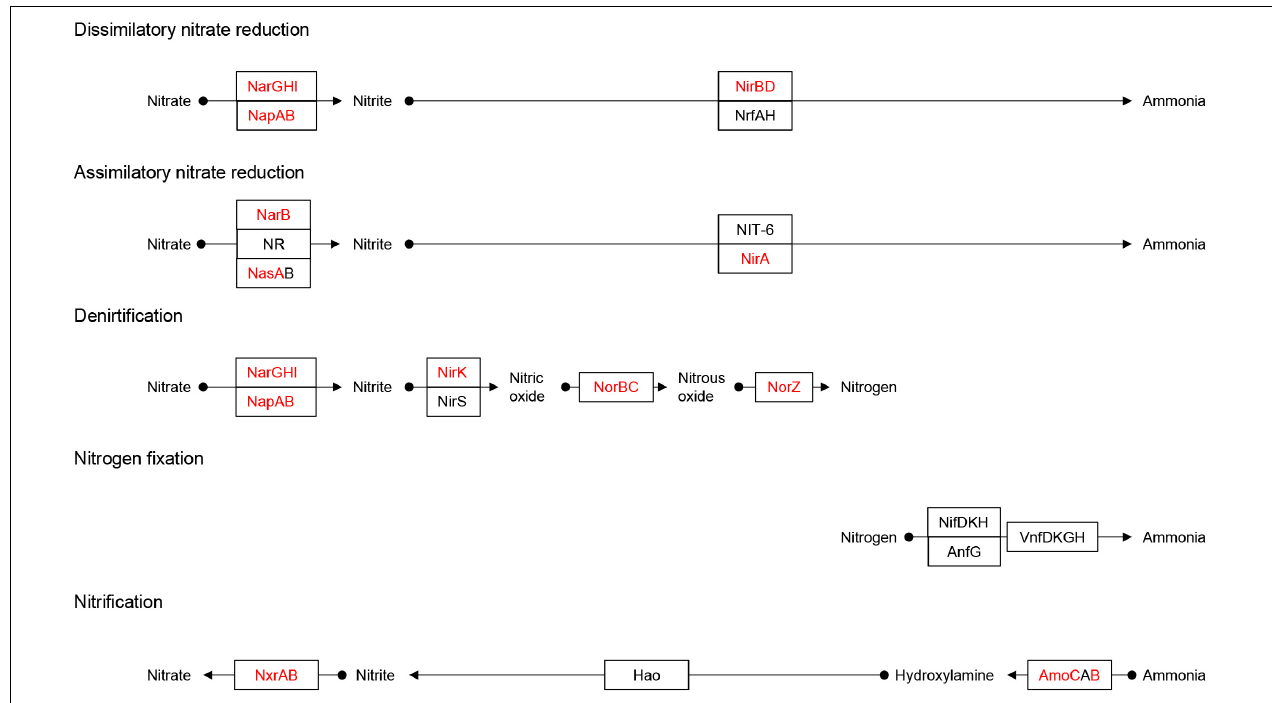
FIGURE 4 | Identification of the Nitrogen metabolism pathway. Adapted from KEGG (https://www.kegg.jp/pathway/map00910). Solid black circles indicate chemical compounds. Squares indicate gene names. The red fonts in the square indicates the names of genes identified in the MAGs, and the black fonts indicates genes that were not identified. The arrow indicates the direction of the reaction